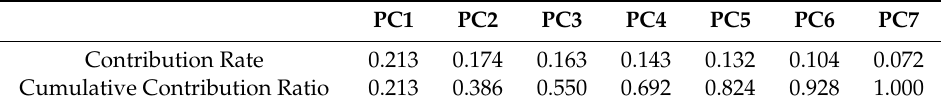
Table 3. Contribution rates of principal component analysis (PCA) with seven